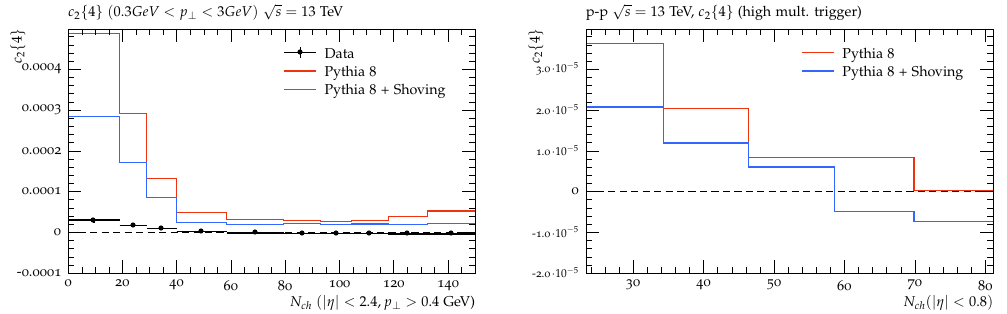
√ s = 13 TeV by ALICE [98].